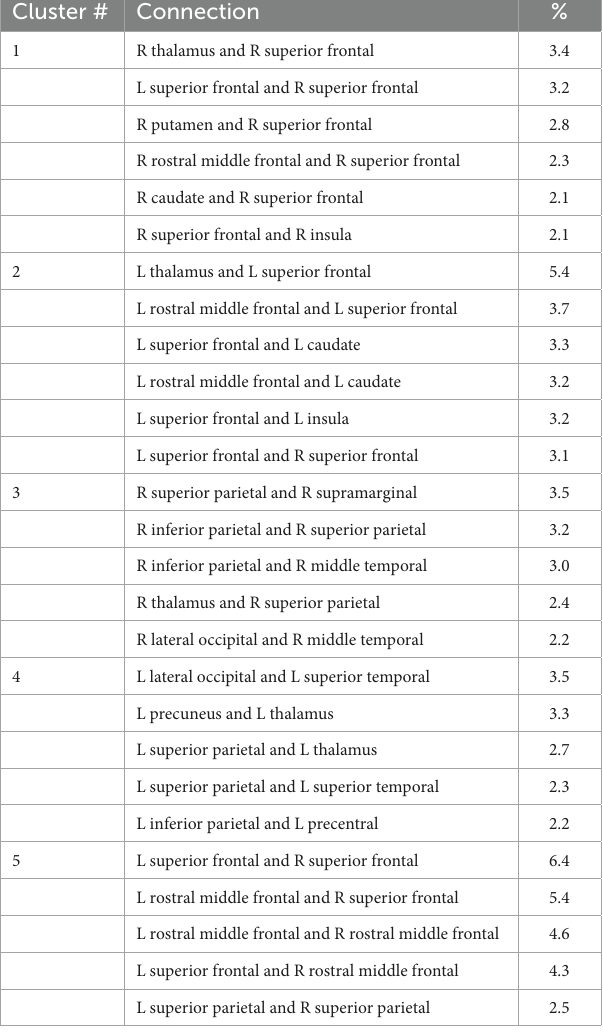
List derived from “regionconnect” tool running on the IIT Human Brain Atlas (v.5.0). The last column shows the % probability that a streamline passing through a voxel of the cluster belongs to a certain connection. Connections with lower probabilities not